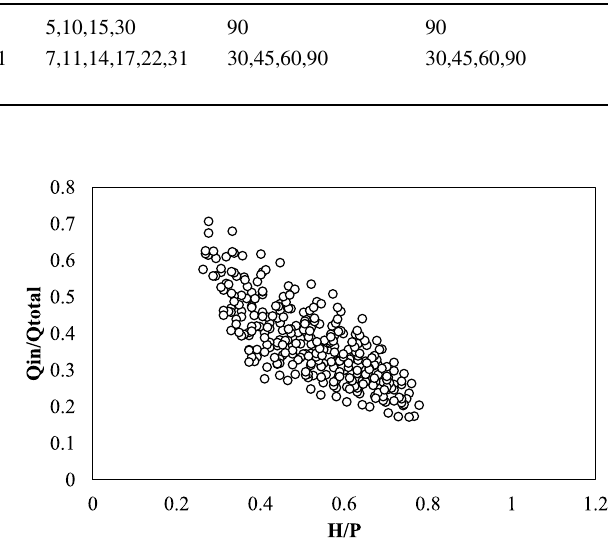
Table 1 Geometrical and hydraulic characteristics of gabion weirs from experimental studies Data source